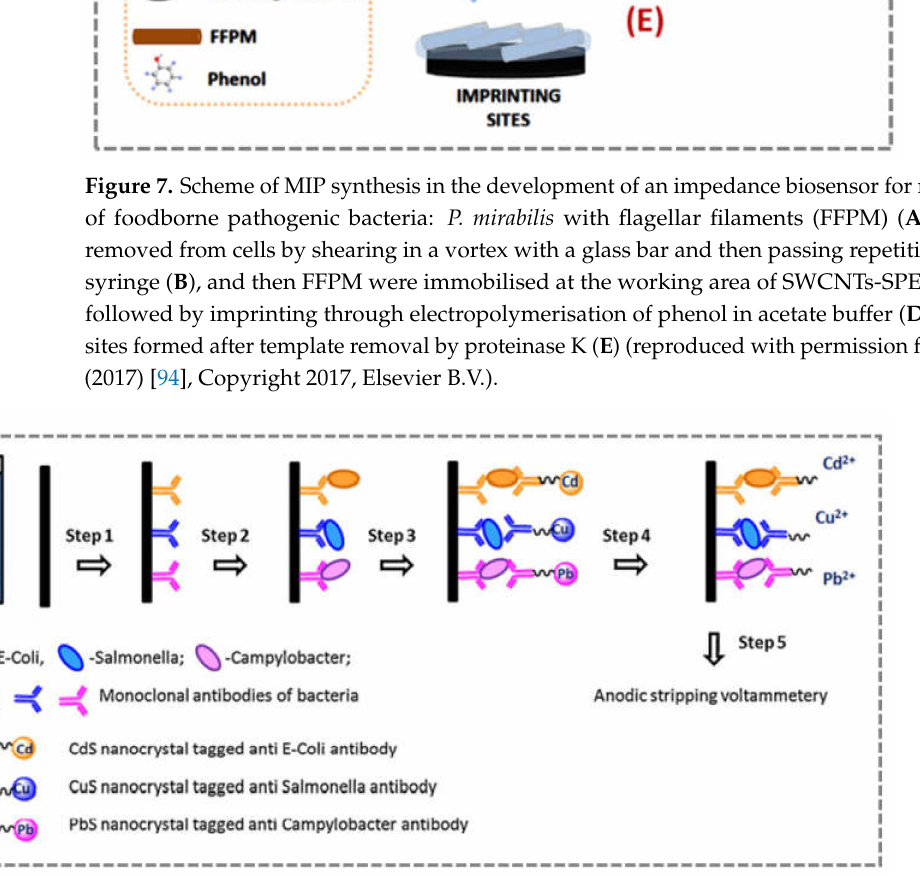
Figure 8. Scheme for multiplex detection of pathogens using nanocrystal antibody conjugates and MWCNT-PAH/SPE. Step 1 is the immobilisation of antibodies, followed by immunocapture (step 2), immunobinding of the conjugates (step 3), dissolution of metal ions from nanocrystals (step 4), and the SWASV analysis (step 5). (Reproduced with permission from Viswanathan et al. (2012) ([95], Copyright 2012, Elsevier